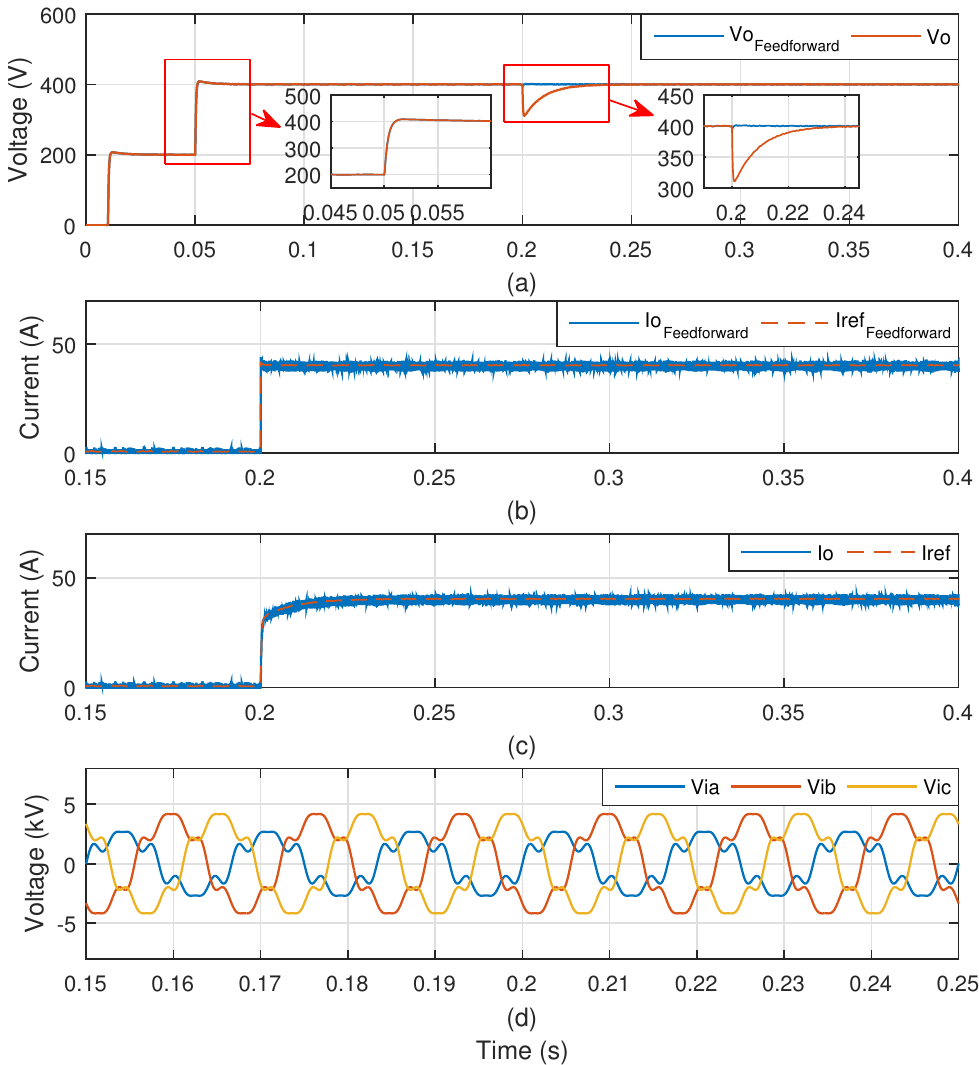
Figure 15. AC-DC 3 × 2 DMC operation with PI 1 ( s ) . ( a ) Output voltage with and without feedforward, ( b ) output current with feedforward, ( c ) output current without feedforward, and ( d ) distorted and unbalanced input